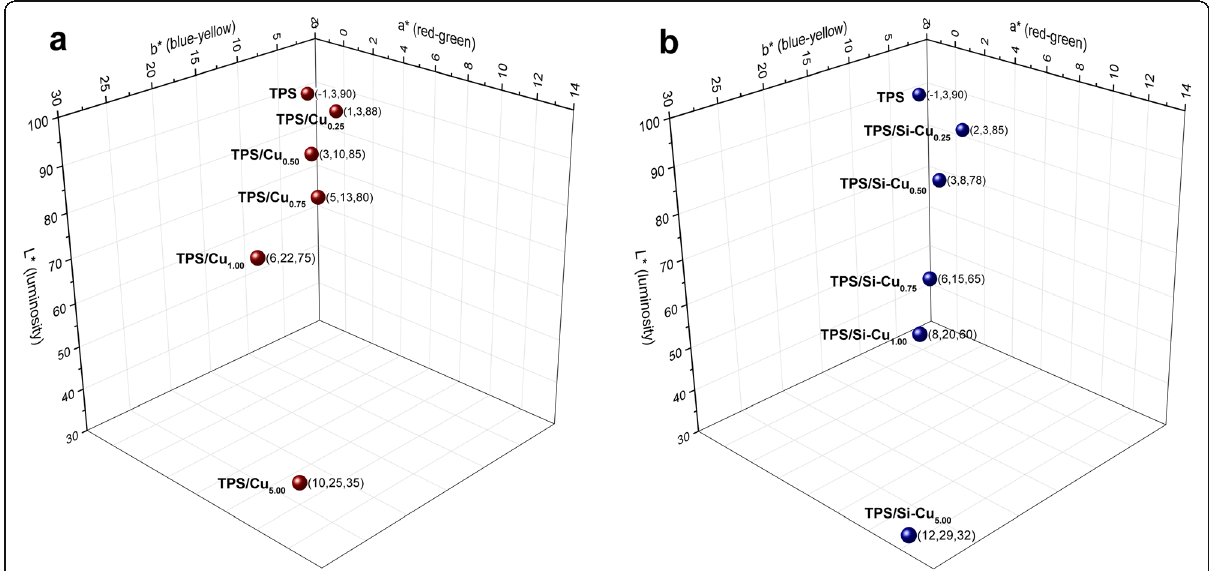
Fig. 3 Luminosity (L*) and color parameters (a* and b*) of TPS composite films containing a ) Cu particles and b ) Si-Cu particles. Numbers between parentheses corresponds to L*, a*, and b*